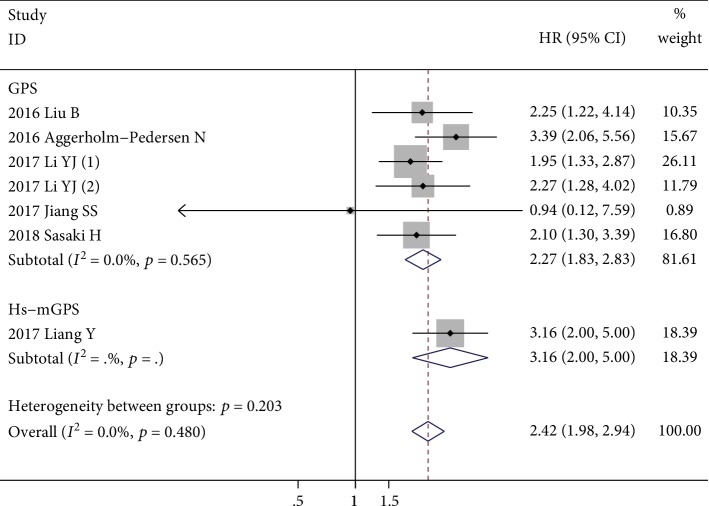
The forest plot about the association between elevated GPS and OS. The pooled effect was calculated using a fixed-effects model.